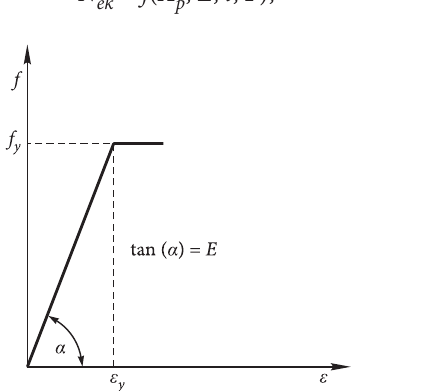
Fig. 1. Physical model of ideal elastic–plastic